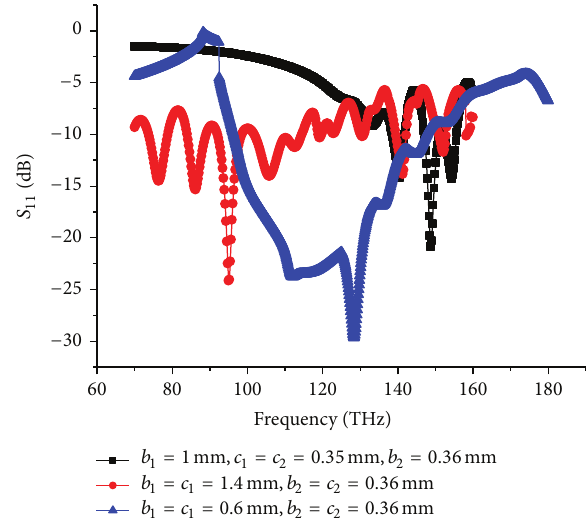
Figure 9: The return loss of 100GHz rectangular antennas ( ℎ = 1.3𝜆 ).